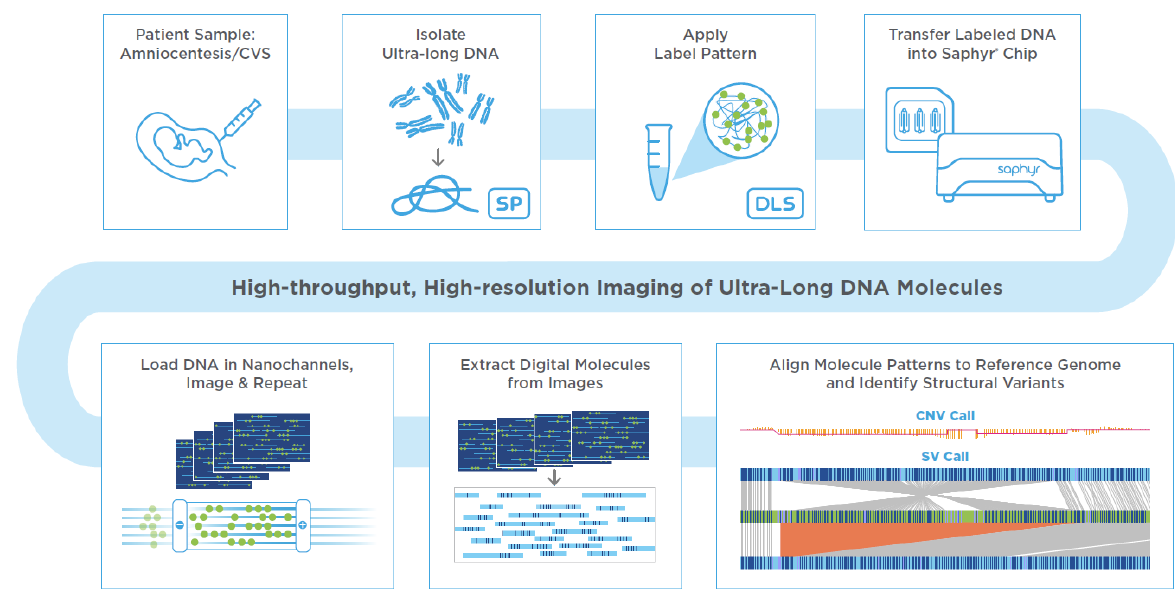
Figure 1. Prenatal workflow for optical genome mapping. From top left to bottom right: Sample format can be from 1 million cells, cultured or directly from cells contained in amniotic fluid or chorionic villus sampling (CVS) sample and can be fresh or frozen. DNA is subsequently labelled at a 6 bp motif by the DLS labeling technology creating a label pattern that spans the whole genome and is unique to each individual sample. Labelled DNA is then loaded on a Saphyr Chip where DNA molecules are electrophoresed into nanochannels where they are uniformly linearized for imaging by the Saphyr instrument in repeated cycles. Images are processed to extract molecules that contain the linear positions of sequence motif labels. Multiple molecules are used to create consensus genome maps representing different alleles from the sample. The sample’s unique optical genome map is aligned to the reference genome and differences are automatically called, allowing for detection of structural variations in a genome wide fashion. (Image modified from: https://bionanogenomics.com, accessed on 2 December 2021).